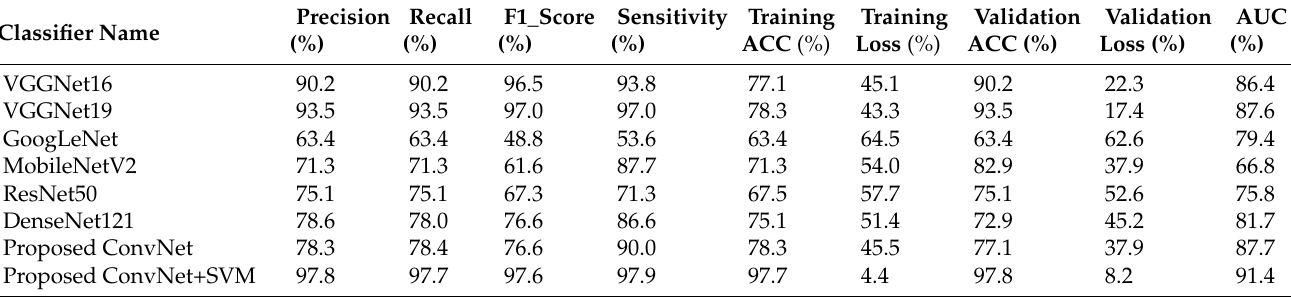
Table 4. Performance analysis of all proposed models in terms of accuracy, precision, recall, F1-score, and area under the curve (AUC)